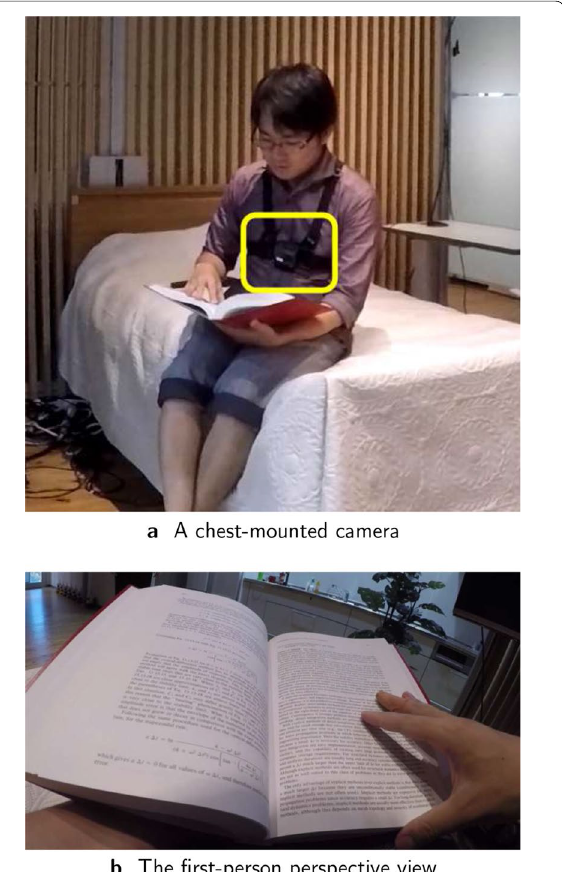
Fig. 7 Setup of a wearable camera. a A wearable camera mounted on the chest (yellow box). b The corresponding first-person image acquired from the